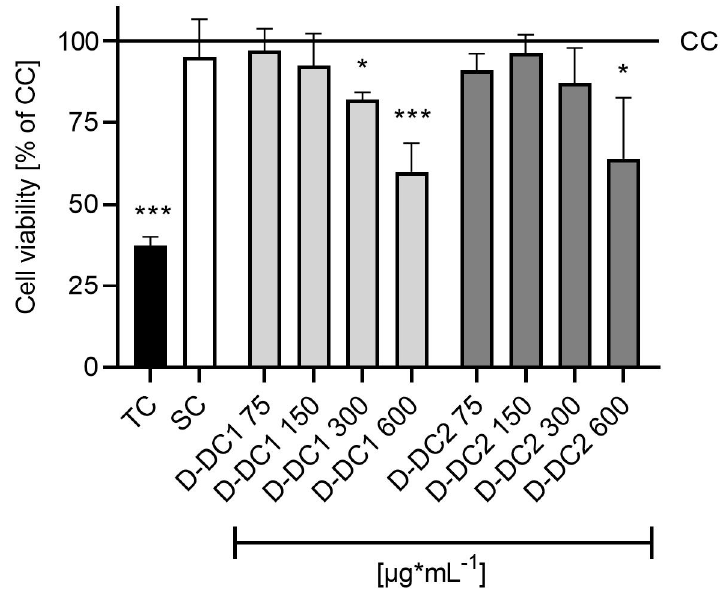
Figure A1. Pre-trial to determine the effects of extracts D-DC1 and D-DC2 on the viability of PBMC over a concentration range. Product extracts were tested at 75–600 µg/mL. Cell viability was determined using the WST-1 cell proliferation assay. Bars and error bars represent means and standard deviations from 3 independent trials, using PBMC isolated from the blood of 3 different pigs (n = 3). Untreated CC was set to 100% and is represented as a solid line in the graph. A toxicity control (TC) with cytotoxic effects, as well as a solvent control (SC) were included. Statistically significant differences compared with the CC are indicated by asterisks (* p < 0.05, *** p < 0.001).